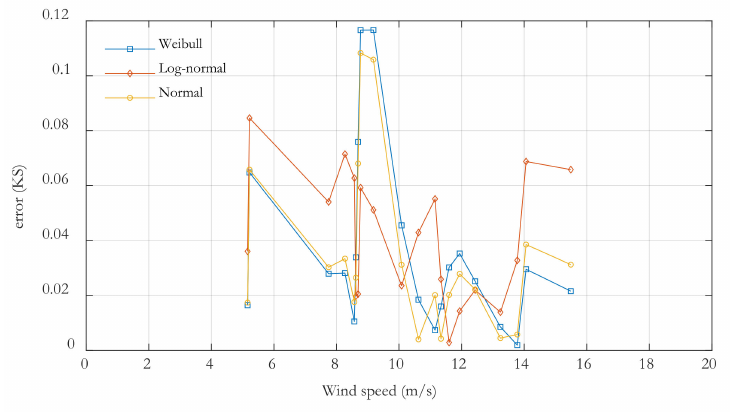
Figure 8. Comparison of CDFs.